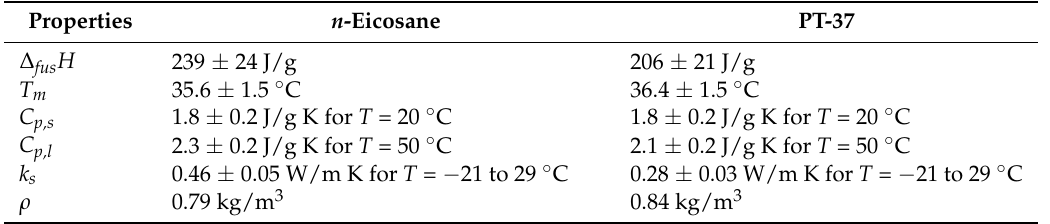
Table 1. Thermophysical properties of n -eicosane and PT-37